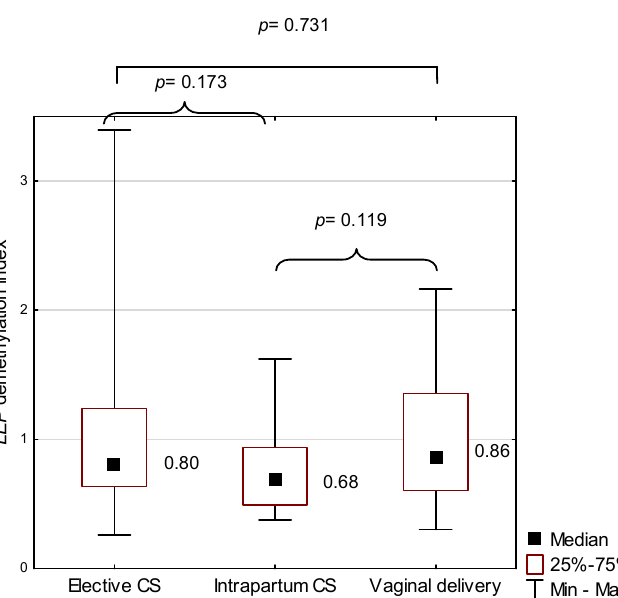
Figure 5. LEP demethylation index against the mode of birth; p represents results from the Mann– Whitney U test to compare LEP demethylation index between two modes of birth. CS—cesarean section. Table 5. Correlations between LEP demethylation index and maternal or neonatal A positive correlation was found between LEP demethylation in the placenta and 40 parity in the vaginal delivery group ( r = 0.606; p = 0.001). LEP demethylation index was not correlated with the maternal and gestational ages, pre- and intragestational BMI, in- tragestational weight gain, newborn weight and gender, or 1 and 5 min Apgar score in every mode of delivery (Table 5).